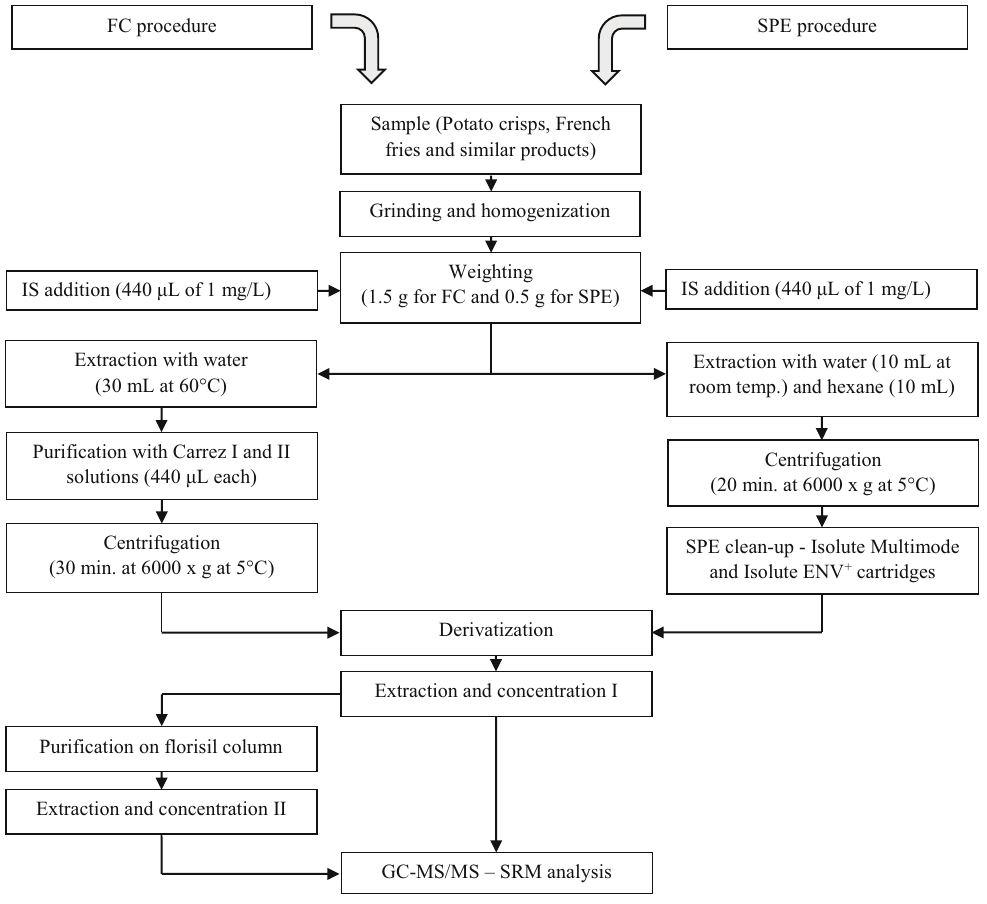
Figure 1: Diagram of the sample preparation steps based on the FC procedure and optimal conditions for SPE